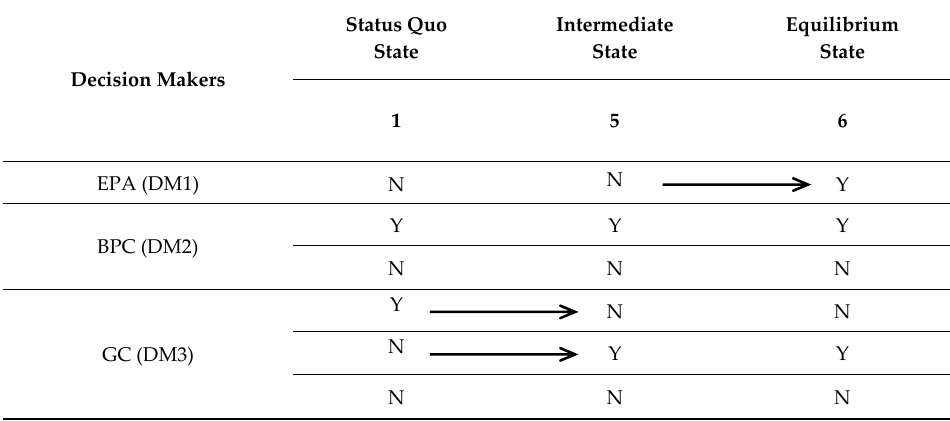
Figure 5. Evolution of the conflict from the status quo through an intermediate state to the final resolution.